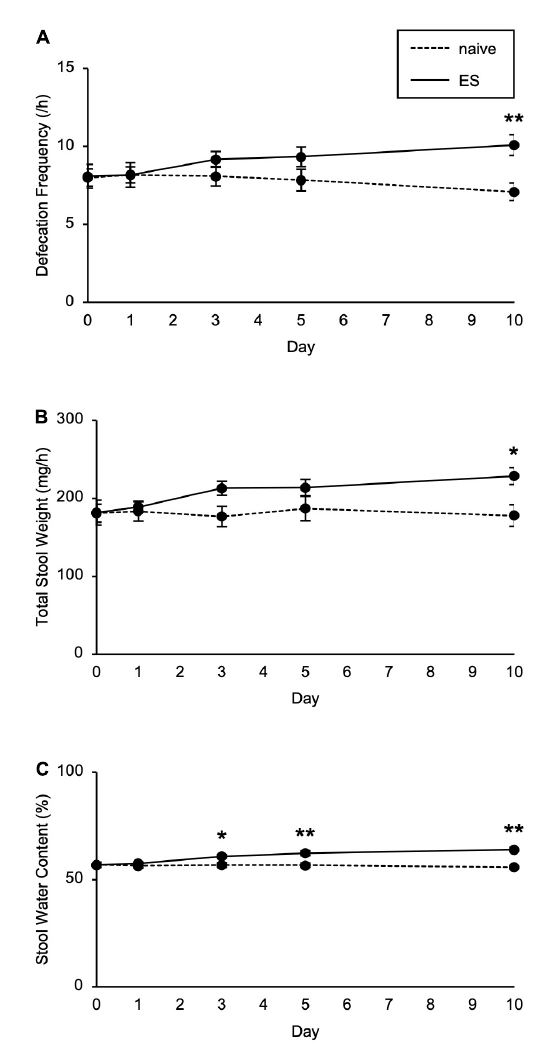
FIGURE2 Chronic vicarious social defeat stress increased defecation frequency and stool water content. (A–C) Defecation frequency (A) , total stool weight (B) , and stool water content (C) for 1 h on different days during the stress session. Data are presented as means ± s.e.m. Data were analyzed using two-way repeated measures ANOVA, followed by Bonferroni’s post hoc test. * p < 0.05, ** p < 0.01. n = 12 for each group.